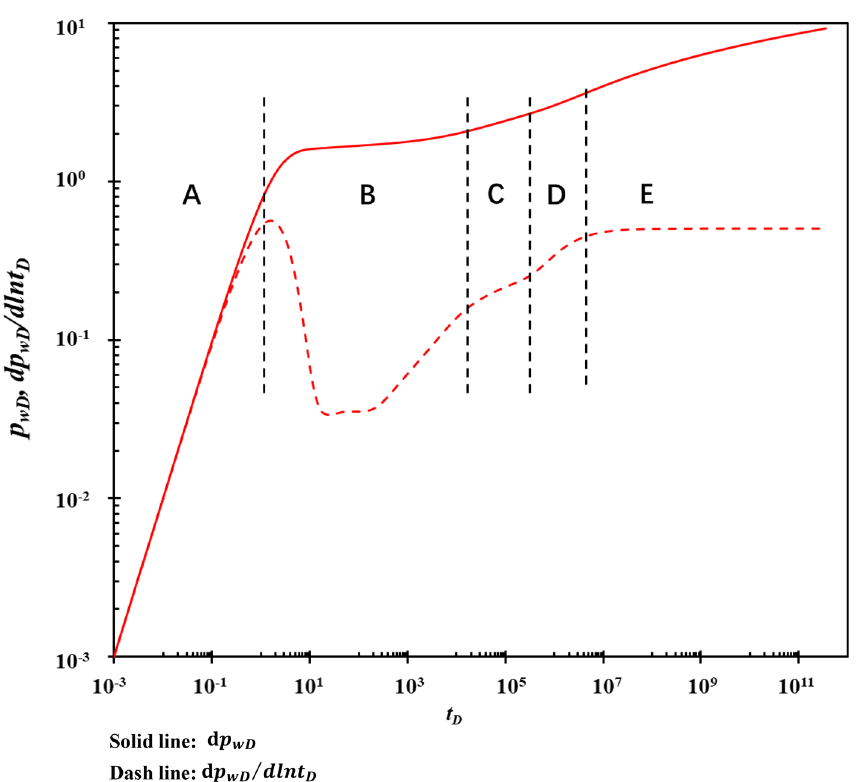
Figure 8. The flow division schematic of the type